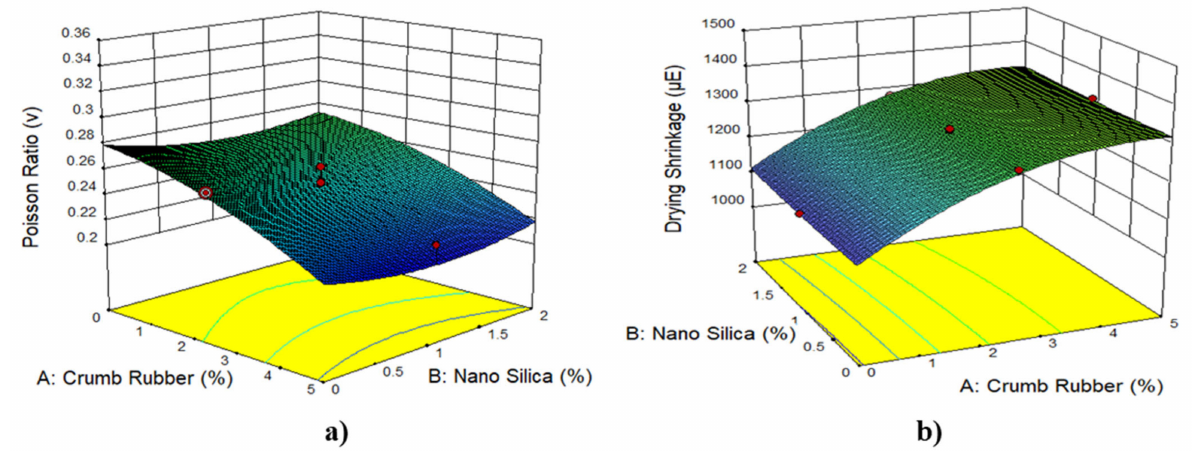
Figure 6. The 3D response surface plots for 25% fly ash and 1% PVA fiber for ( a ) Poisson’s ratio and ( b ) drying shrinkage.